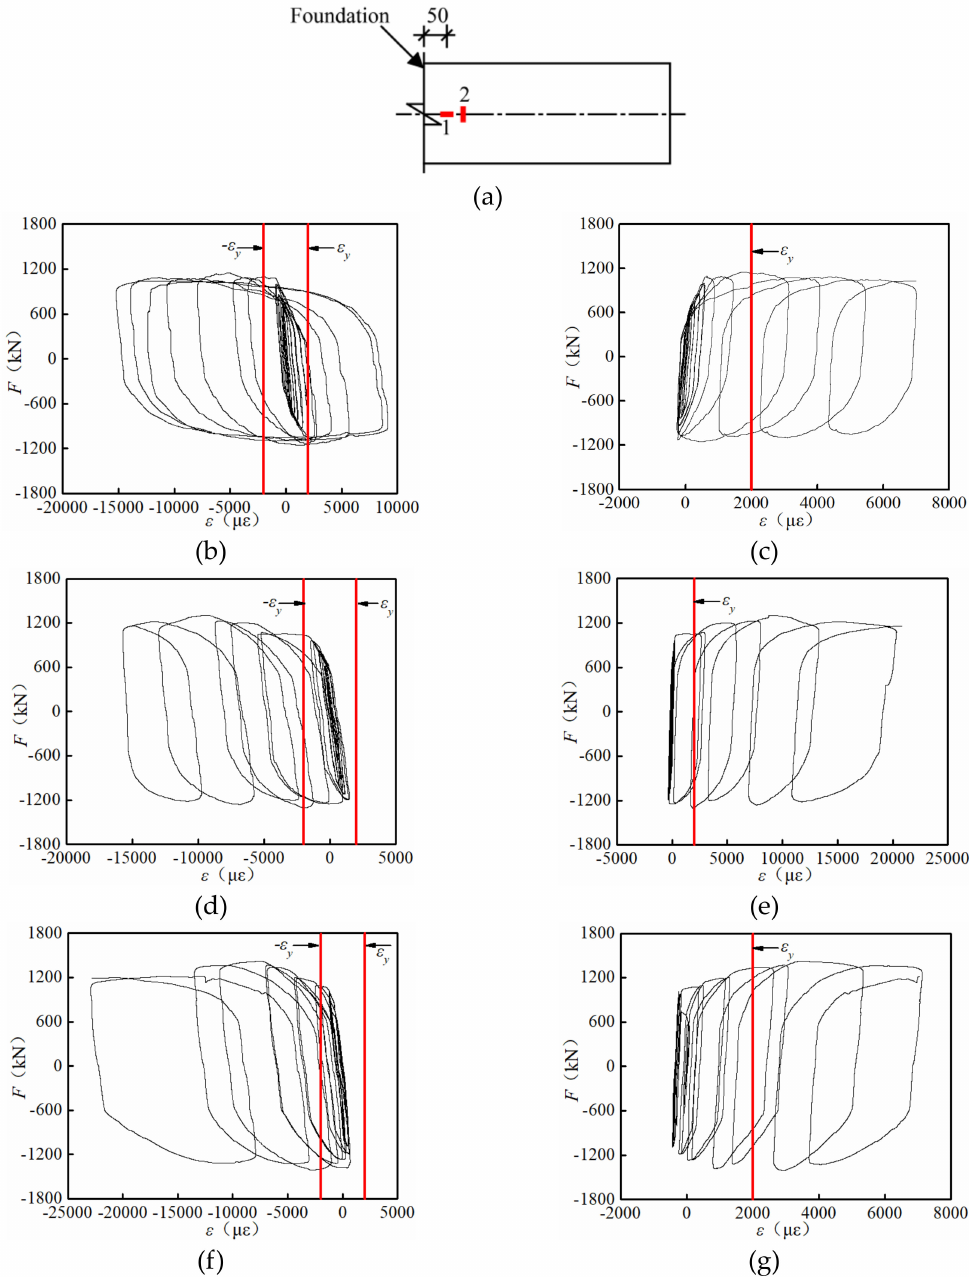
Figure 13. Lateral load versus steel strain relations. ( a )positions of strain gauges on the bottom surface of steel tube; ( b ) Strain1 (CFST-SR); ( c ) Strain2 (CFST-SR); ( d ) Strain1 (CFST-DT); ( e ) Strain2 (CFST-DT); ( f ) Strain1 (CFST-MC); and ( g ) Strain2